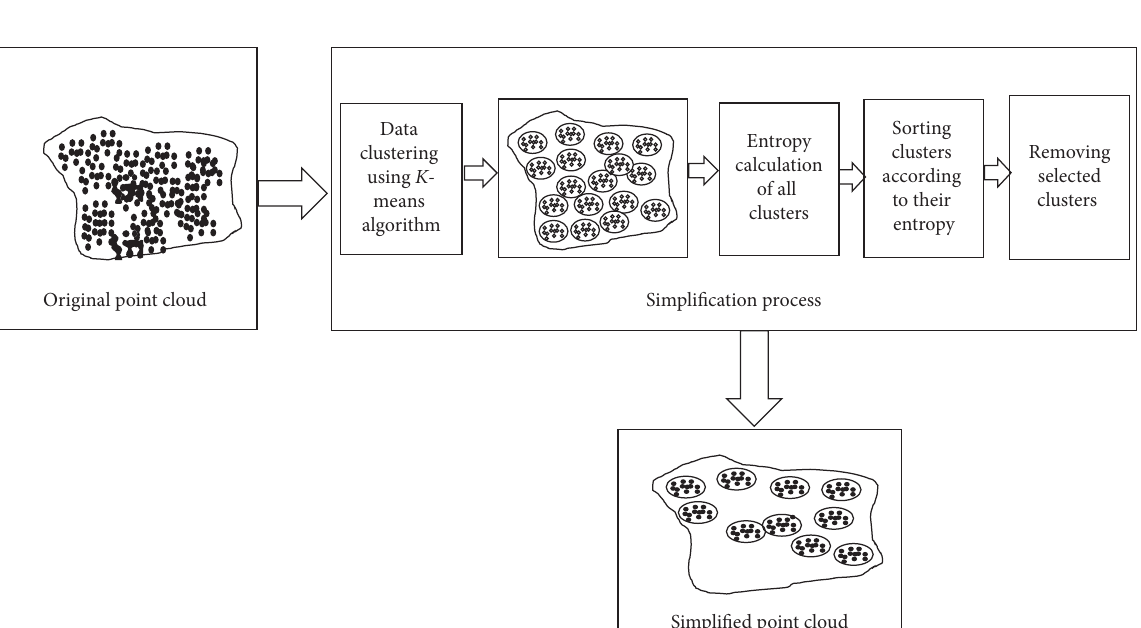
Figure 2: A diagram that shows how the new point cloud simplification method